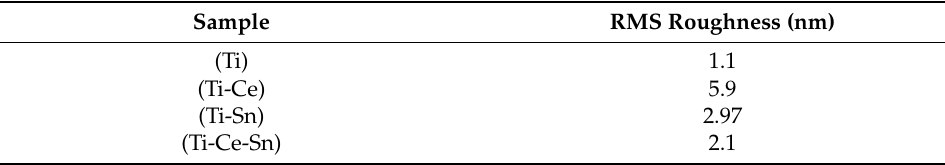
Figure 3. AFM images of TiO 2 -Me x O y films. Table 1. The roughness of the prepared